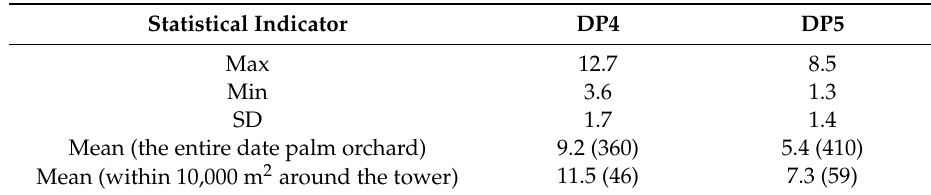
Table 4. Statistical indicators of trees height (m) at sites DP4 and DP5. The living trees in each of these date palms were considered in the calculations. The number of trees is given in parentheses. SD represents standard